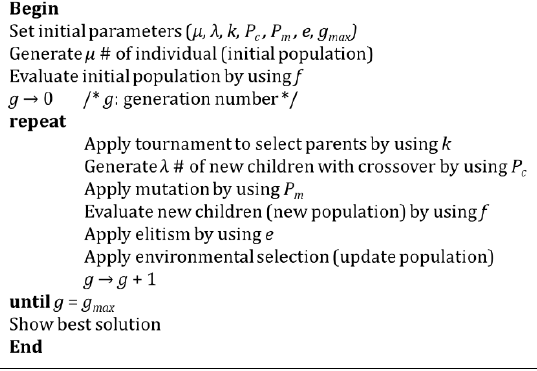
Figure 1. Pseudo-code of developed GA.